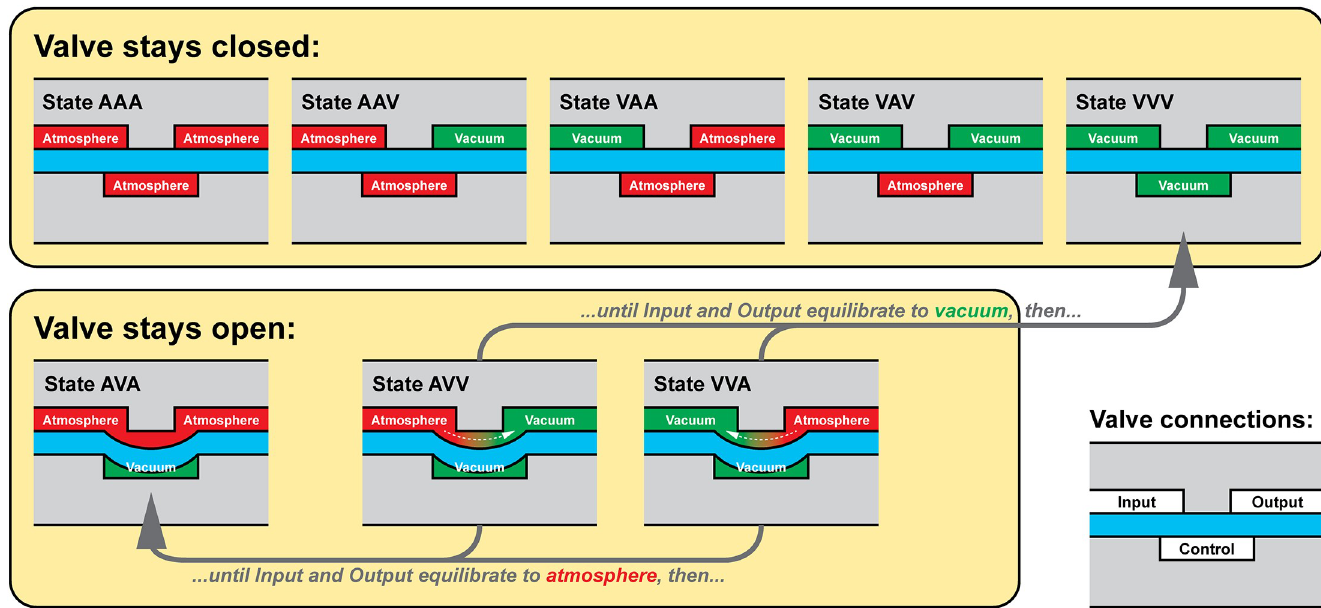
Fig 3. A “truth table” showing cross-sections of a high-flow monolithic membrane valve during each of the eight possible combinations of atmospheric pressure ( A ) and vacuum ( V ) applied to the valve’s three connections (Input, Control, and Output). When atmospheric pressure is applied to all three connections on a valve, the valve has equal pressure applied on both sides of the flexible membrane, so the membrane remains in its resting (closed) state ( AAA ). If the Control connection on a valve receives atmospheric pressure, then the valve will remain closed, regardless of whether the Input and Output connections receive vacuum or pressure ( AAV , VAA , and VAV ). When vacuum is applied to all three connections on a valve, the valve has the same pressure on both sides of the flexible membrane, so the membrane remains at rest and the valve stays closed ( VVV ). If vacuum is applied to the Control connection while the Input and Output connections are at atmospheric pressure, then the pressure differential across the flexible membrane causes the membrane to stretch into the Control chamber and opens the valve ( AVA ). When vacuum is applied to the Control connection and the Output connection while the Input connection is at atmospheric pressure ( AVV ), the valve opens and air flows from the Input to the Output. Likewise, when vacuum is applied to the Control and Input connections while the Output is at atmospheric pressure ( VVA ), the valve opens and air flows from the Output to the Input. In both cases, the valve remains open and air continues to flow as long as there is a pressure difference between the Input and Output connections. However, if the pressures at the Input and Output connections equalize (both become vacuum, or both become atmospheric pressure), the valve will automatically transition to a new state . If both the Input and the Output reach atmospheric pressure, then the valve will transition to state AVA and remain open. But if both the Input and the Output reach vacuum, then the valve will transition to state VVV and automatically close. This automatic transition from state AVV or VVA to state VVV is particularly useful because it can “trap” a vacuum in a region of a pneumatic logic circuit; the vacuum remains trapped until it is vented by opening a path to atmospheric pressure using state AVV or VVA again. This serves as a one-bit nonvolatile pneumatic “memory”: a section of channel represents 1 (TRUE) if it contains a trapped vacuum and 0 (FALSE) if it contains atmospheric-pressure